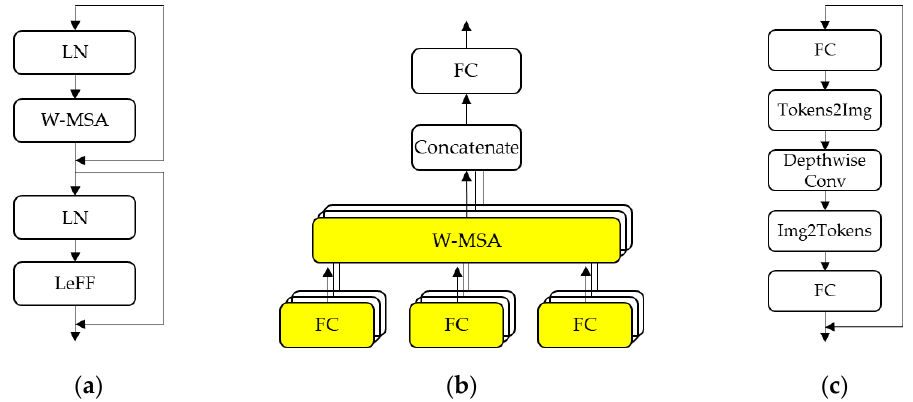
Figure 6. Description of the Transformer block: ( a ) Transformer block; ( b ) illustration of how the W-MSA works; ( c ) structure of LeFF.